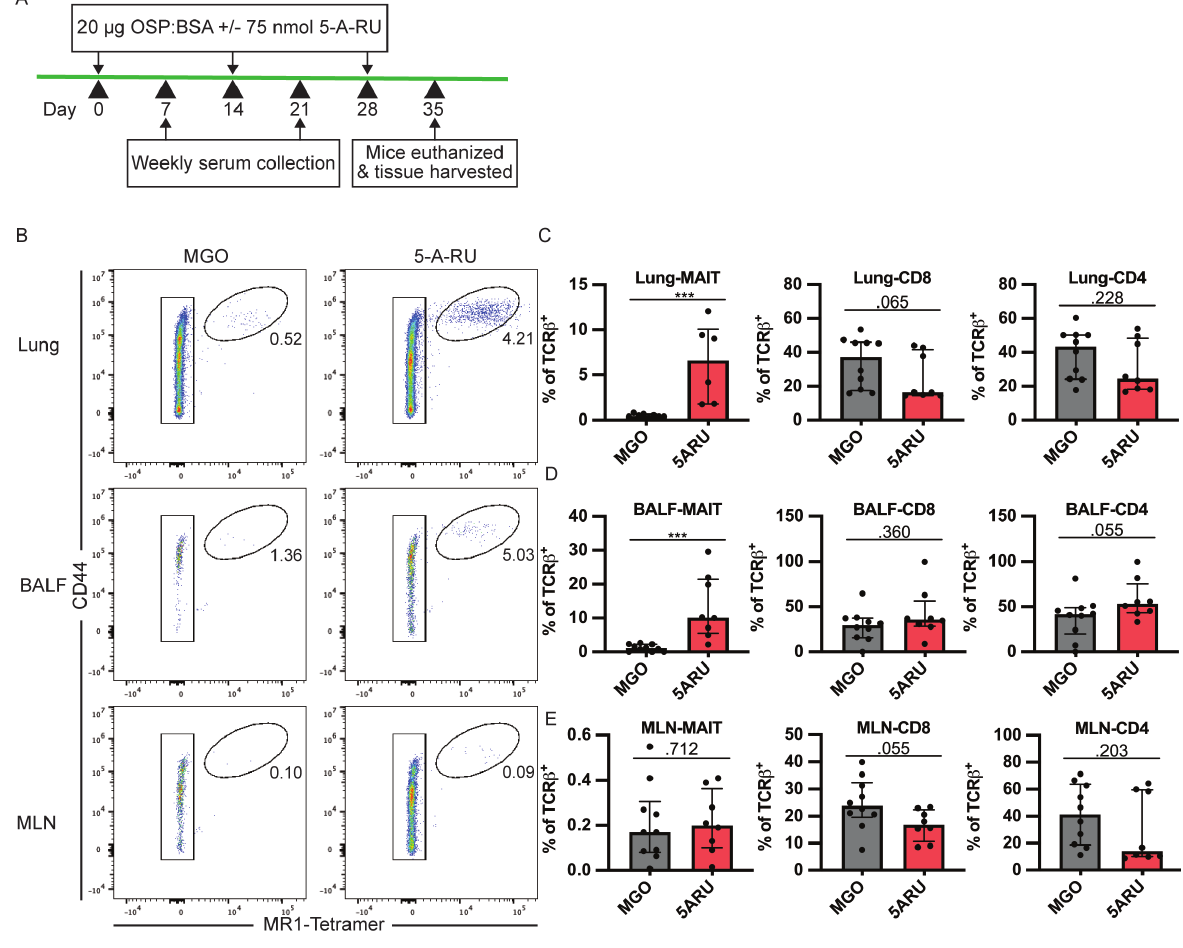
Figure 4. MAIT cells expand following a low-dose 5-A-RU treatment combined with intranasal V. cholerae OSP. ( A ) Intranasal MAIT ligand plus V. cholerae O1 Ogawa OSP:BSA vaccination timeline. ( B ) Representative FACS plots of MAIT cells (CD44 High MR1-Tetramer + ) from lung, BALF, and MLN gated off Live B220 - TCR b + cells. ( C-E ) Frequency of MAIT (left), CD8 (middle), and CD4 (right) T cells as a percentage of TCR b + cells in ( C ) lung, ( D ) BALF, and ( E ) MLN. Data are represented as Median with IQR from 2 independent experiments. n=8-10 mice per group. * P < 0.05, ** P > 0.01, *** P > 0.001, *** P > 0.0001 by 2-tailed Mann-Whitney U